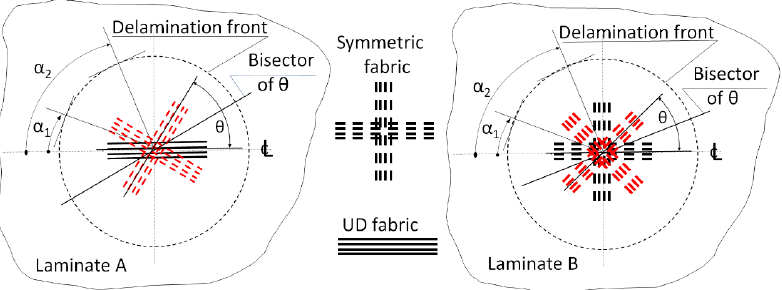
Figure 3. Variation of the reinforcement orientation relative to the front of buckling circular de- lamination.